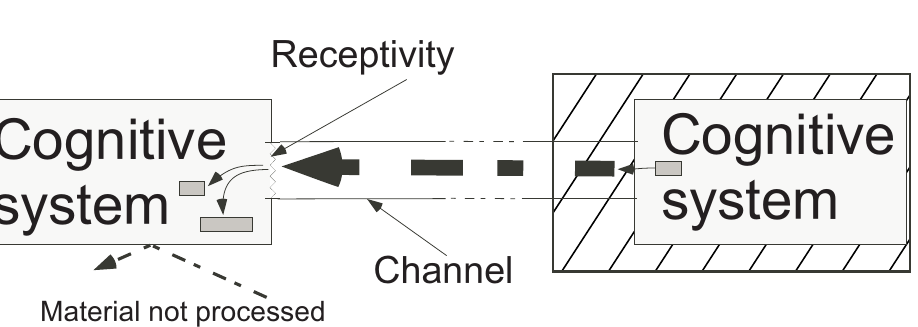
Figure 2. The context of